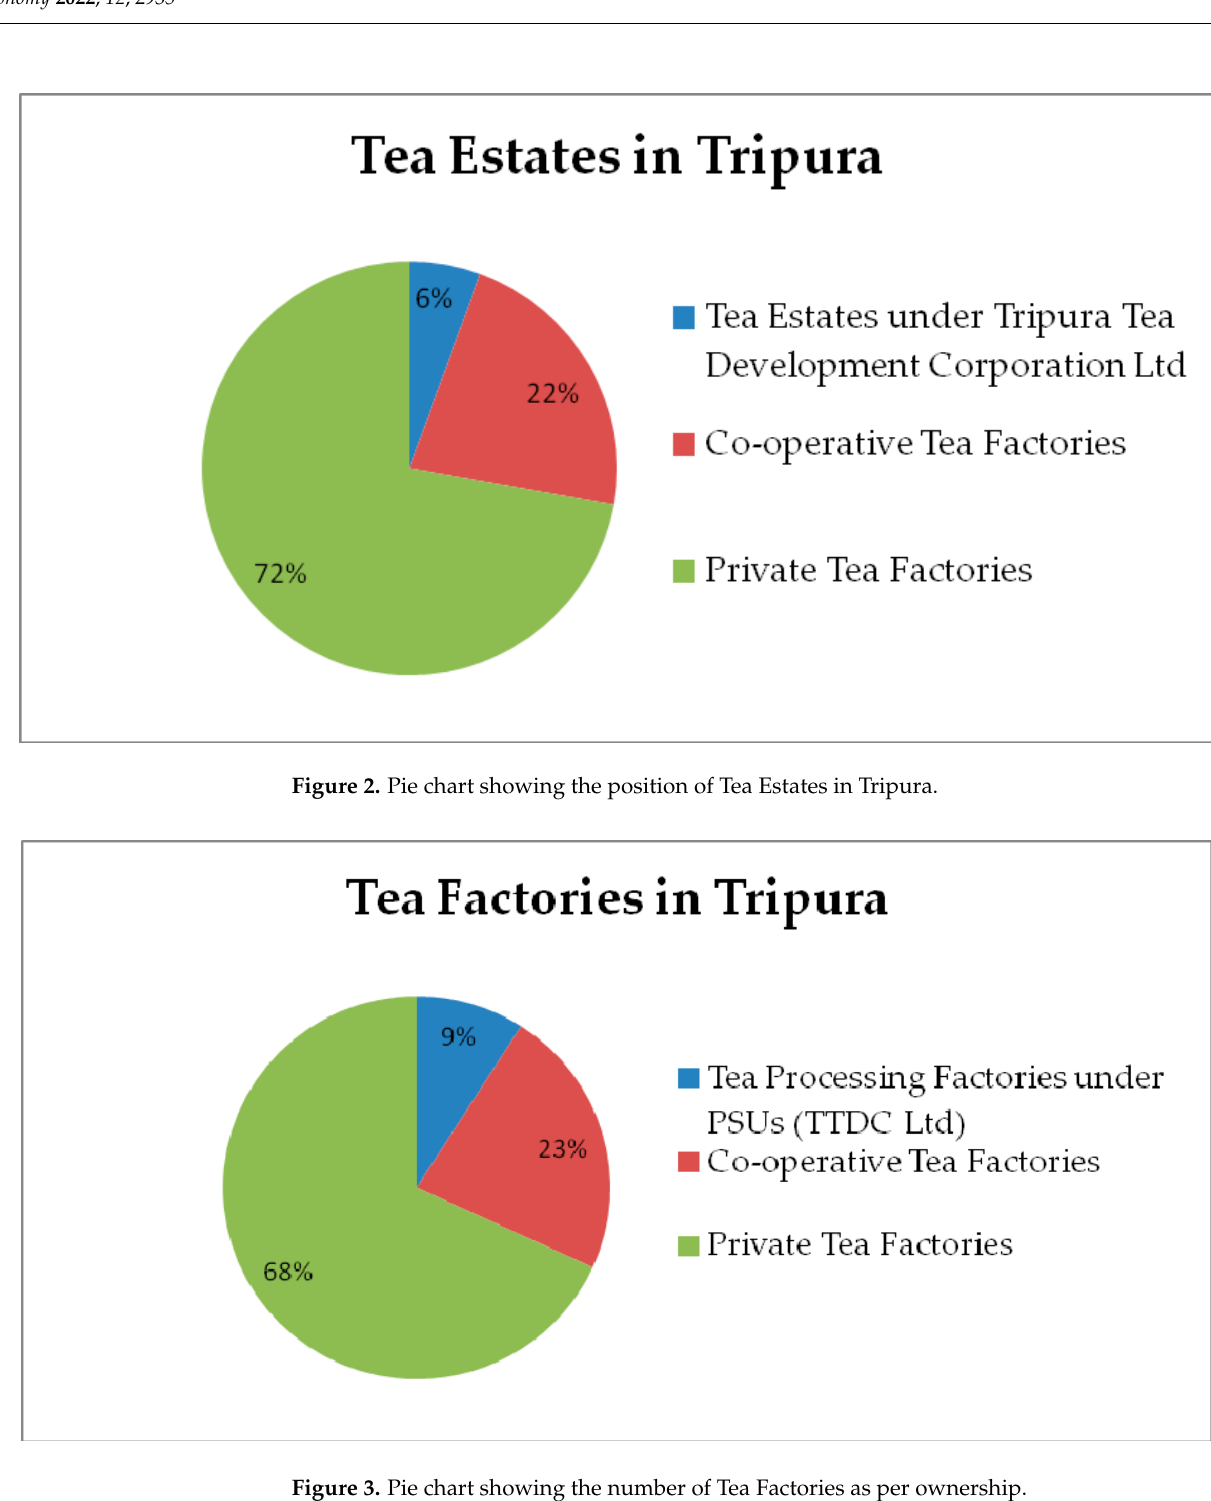
Figure 3. Pie chart showing the number of Tea Factories as per ownership.